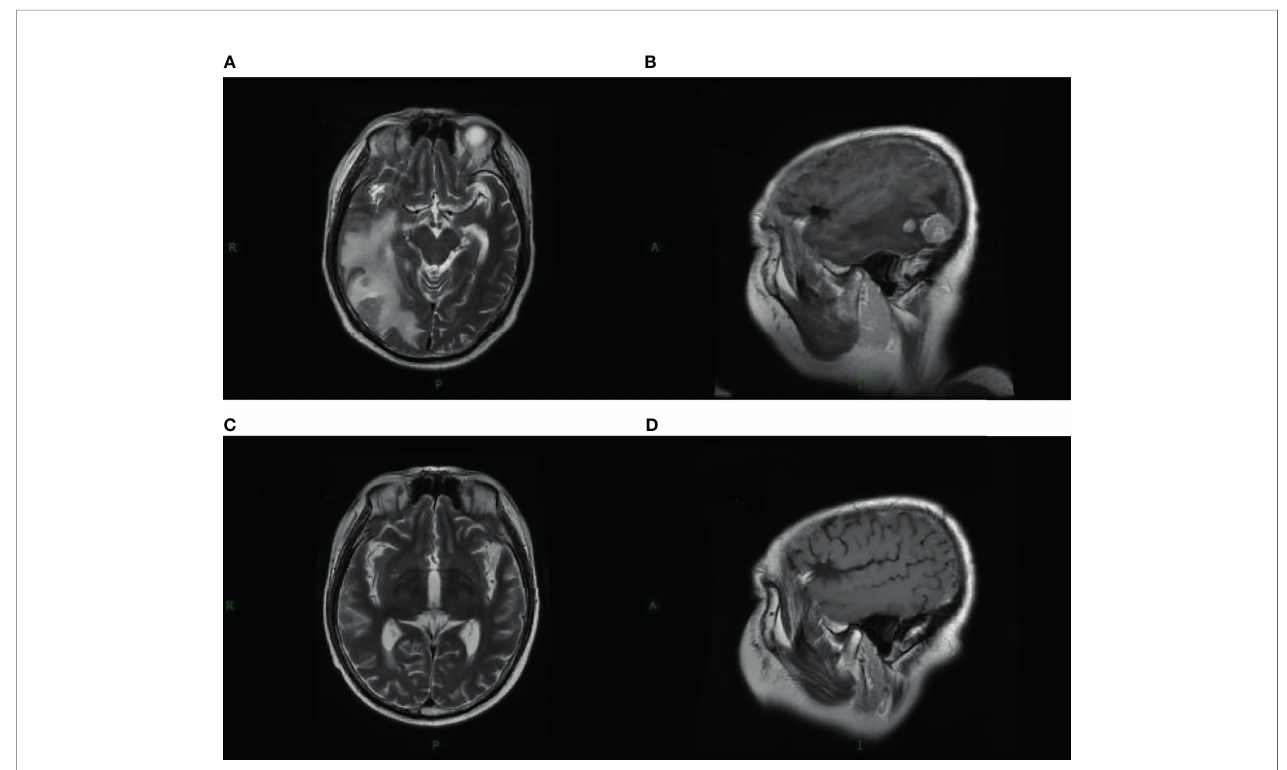
FIGURE 1 | Magnetic resonance imaging (MRI) with contrast enhancement of brain metastasis. (A, B) July 2011, before radiotherapy on brain. (C, D) September 2011, after radiotherapy on the